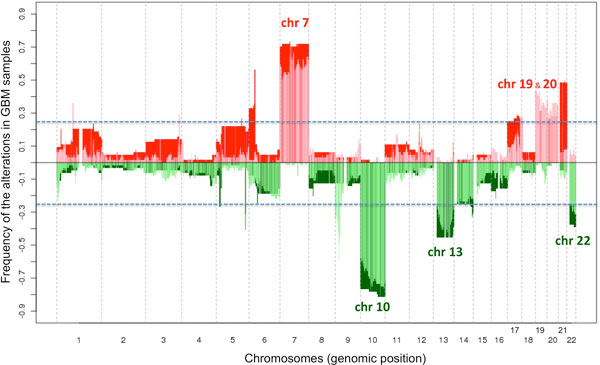
Combined view of GE and CN alterations obtained for the GBM dataset. The regions for all the human chromosomes (chr) that are altered either in CN or in GE are presented along the whole genome keeping the proportional size of the chromosomes. The graph shows the frequency of such alterations in the GBM samples. The colors correspond to GE up-regulated regions (in red) or down-regulated regions (in green), and -plotted on top- the CN gains (in pale red) or the CN losses (in pale green). Blue lines mark the regions that change in more than 25% of the GBM patients. The chromosomes with most significant changes (that present large regions included in the categories U-G or D-L) are labeled: U-G chr 7, chr 19, chr 20; D-L chr 10, chr 13, chr 22.